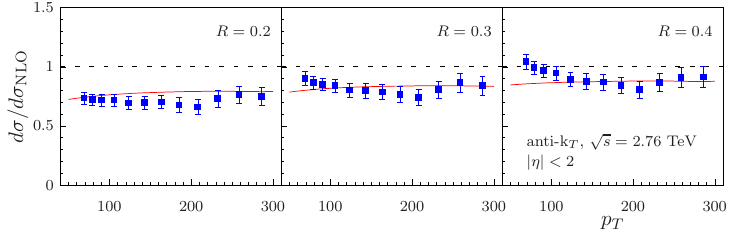
Figure 1. The ln R -resummed jet cross section is compared with the CMS experimental data